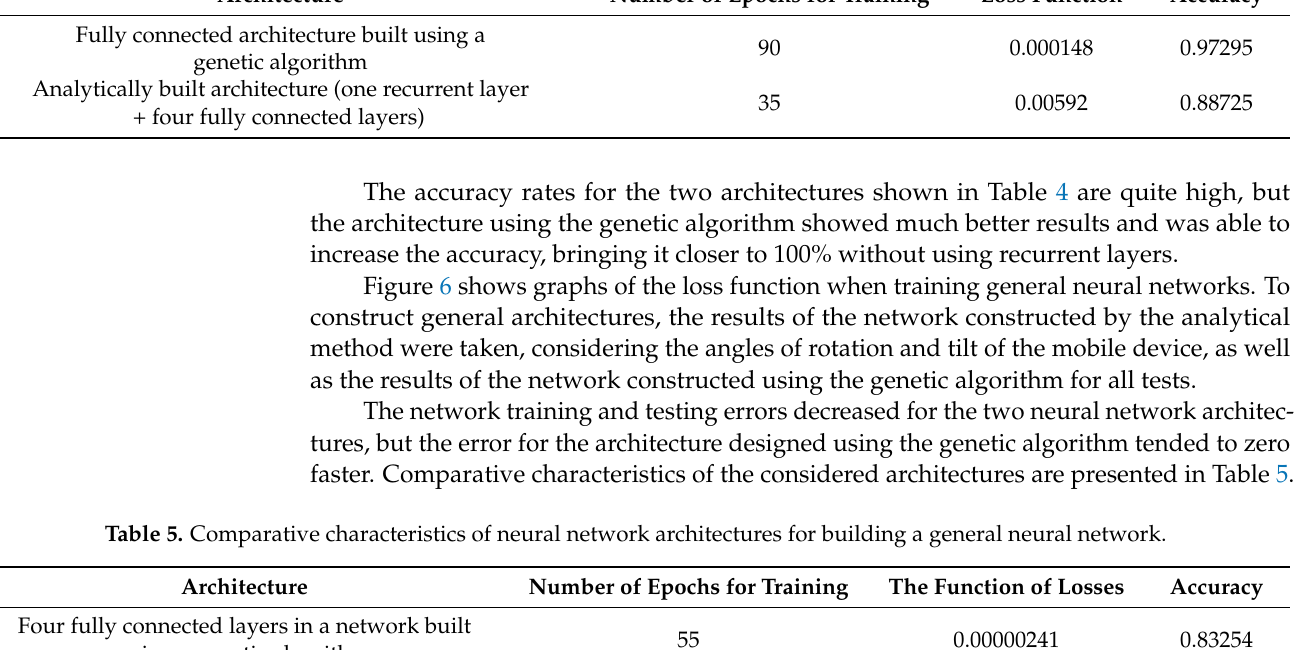
Table 4. Comparative characteristics of architectures for building a neural network based on the data of testing modules.